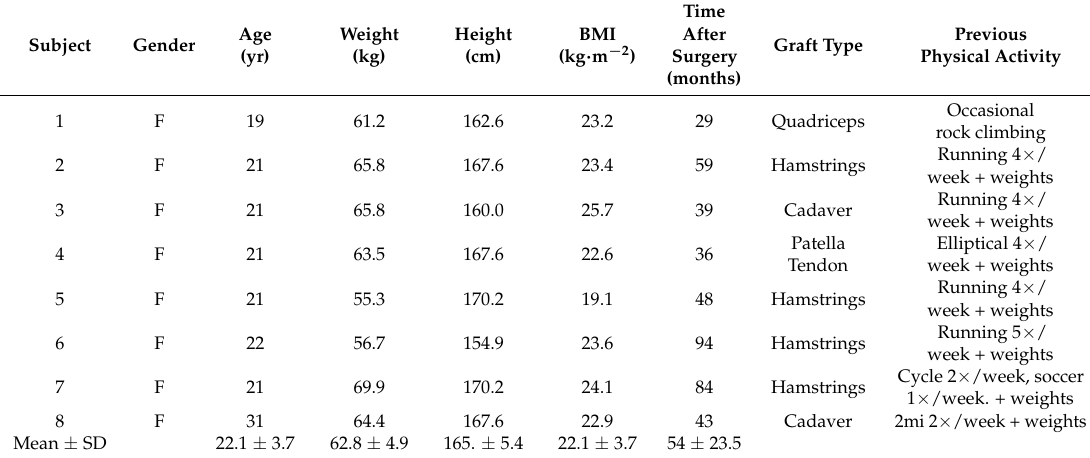
Table 1. Relevant participant